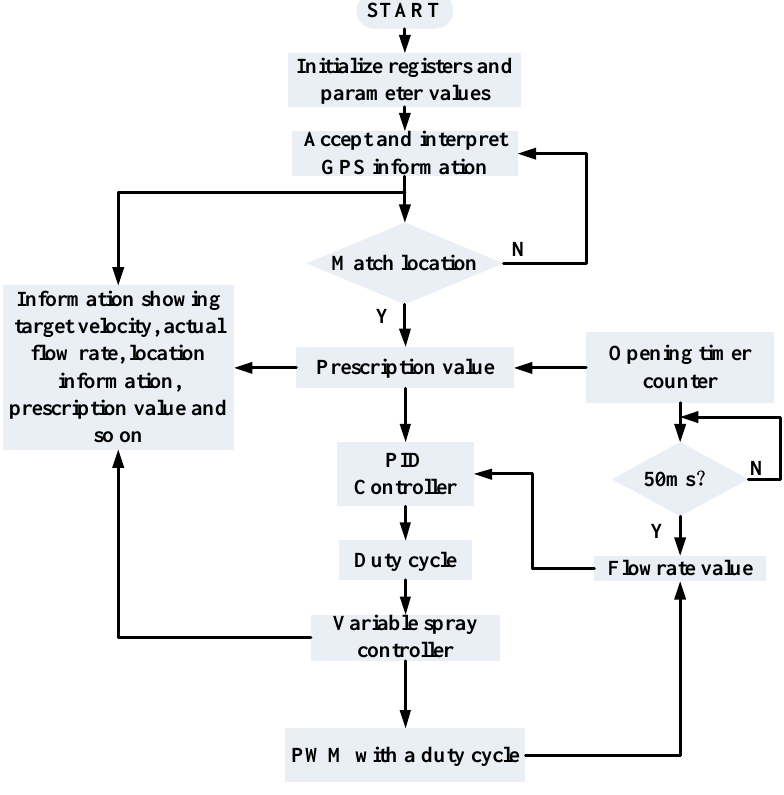
Figure 10. Program flow chart.